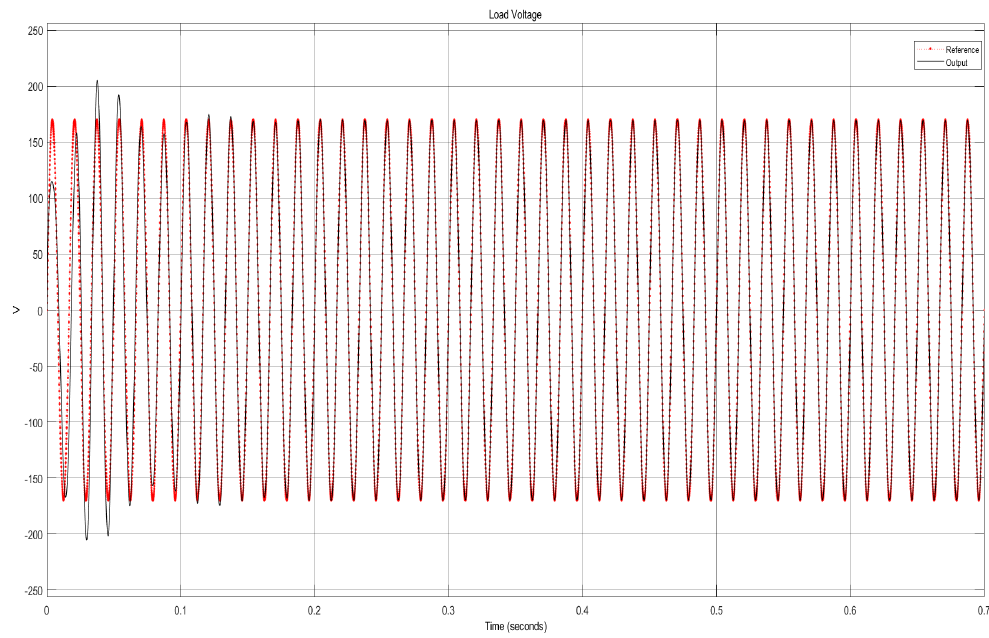
Figure 9. Temporal response of the Load